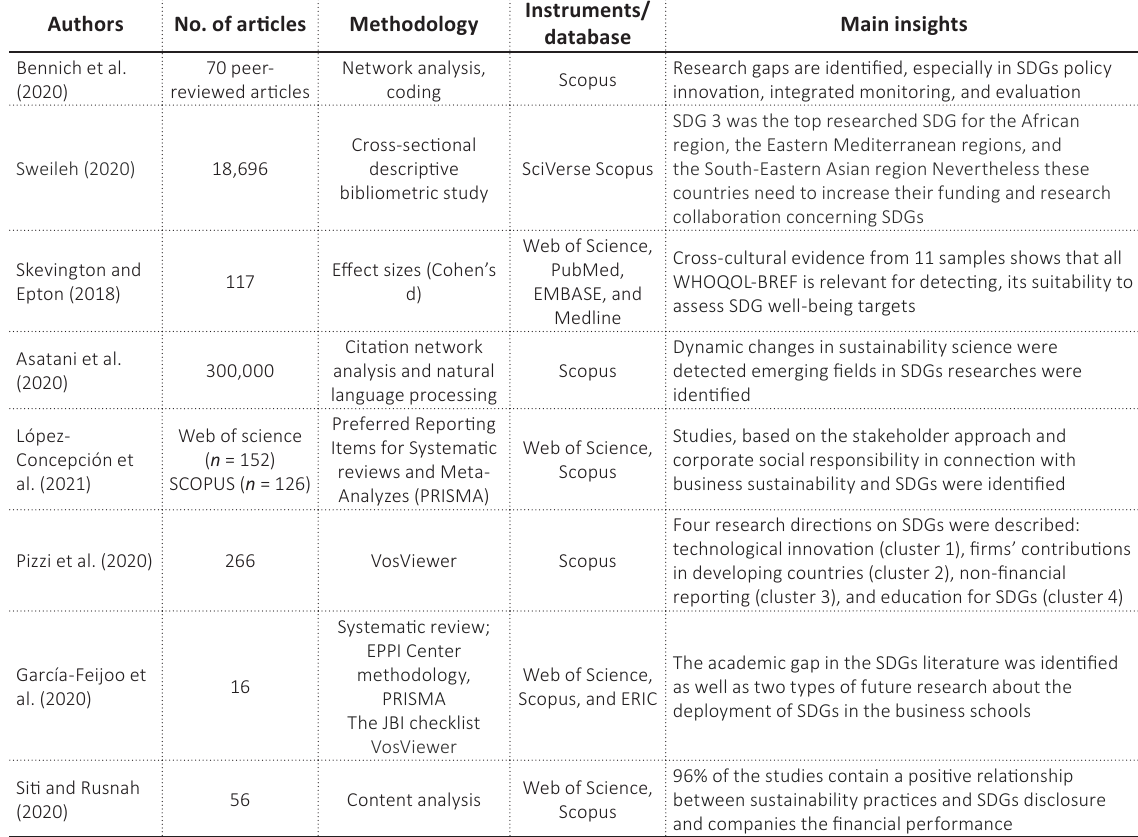
Table 1. Cross-SDGs meta-analysis results of relevant academic